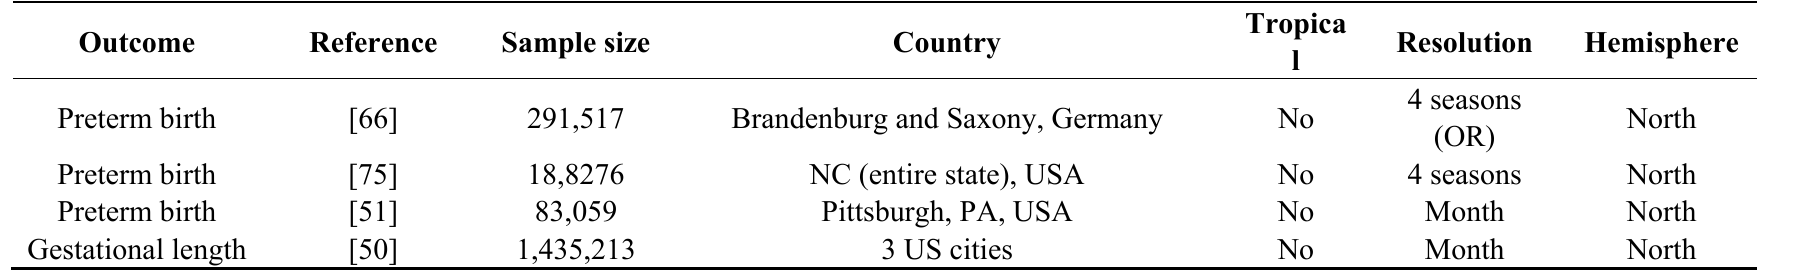
Table A14. Studies examined for the meta analysis of the influence of season of conception on preterm birth and gestational length. Outcome